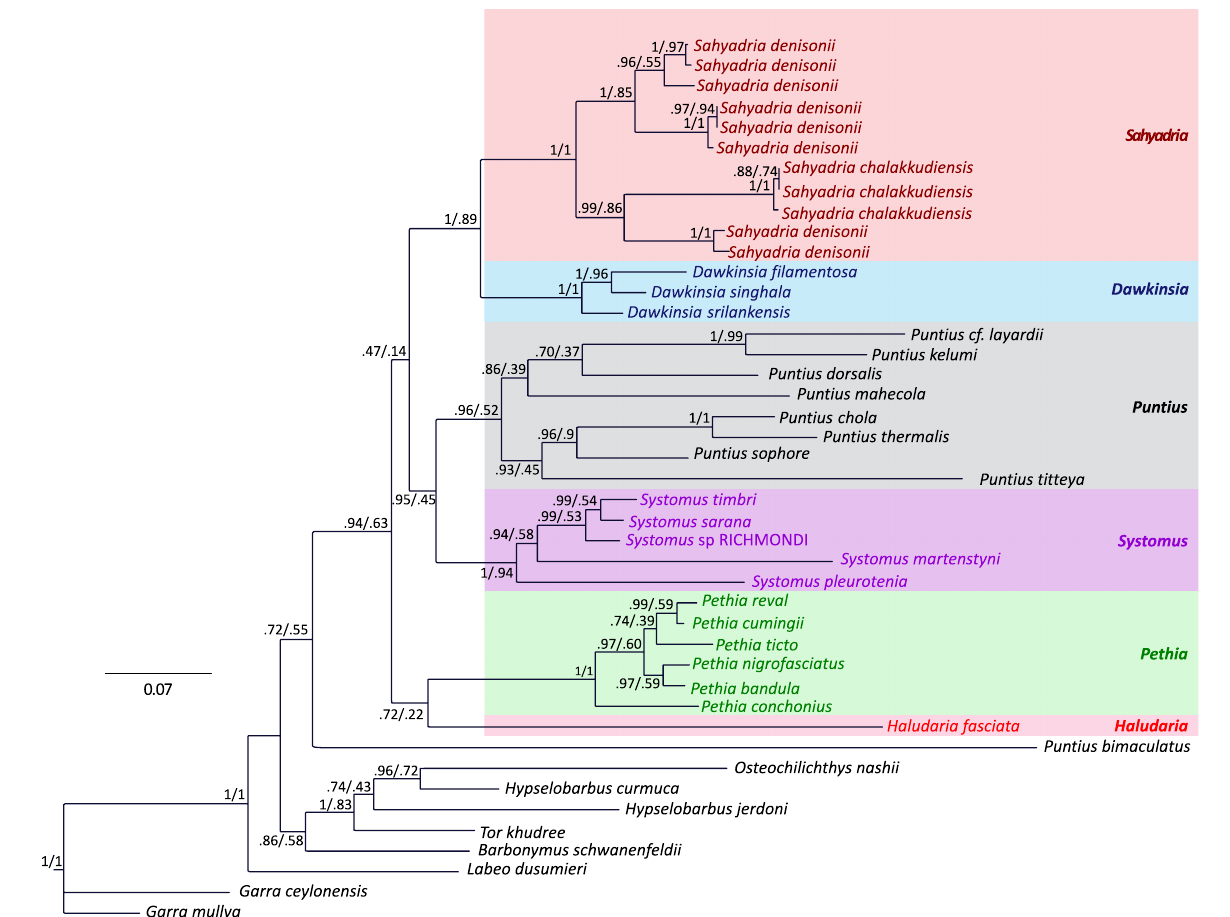
Figure 2. Phylogenetic tree based on concatenated mitochondrial cytochrome b (cytb) and 16s RNA gene sequences (accession numbers: see Pethiyagoda et al. 2012, John et al. 2013 and GQ247528 - GQ247532). Bayesian posteriorprobabilities/ML bootstrap values shown at